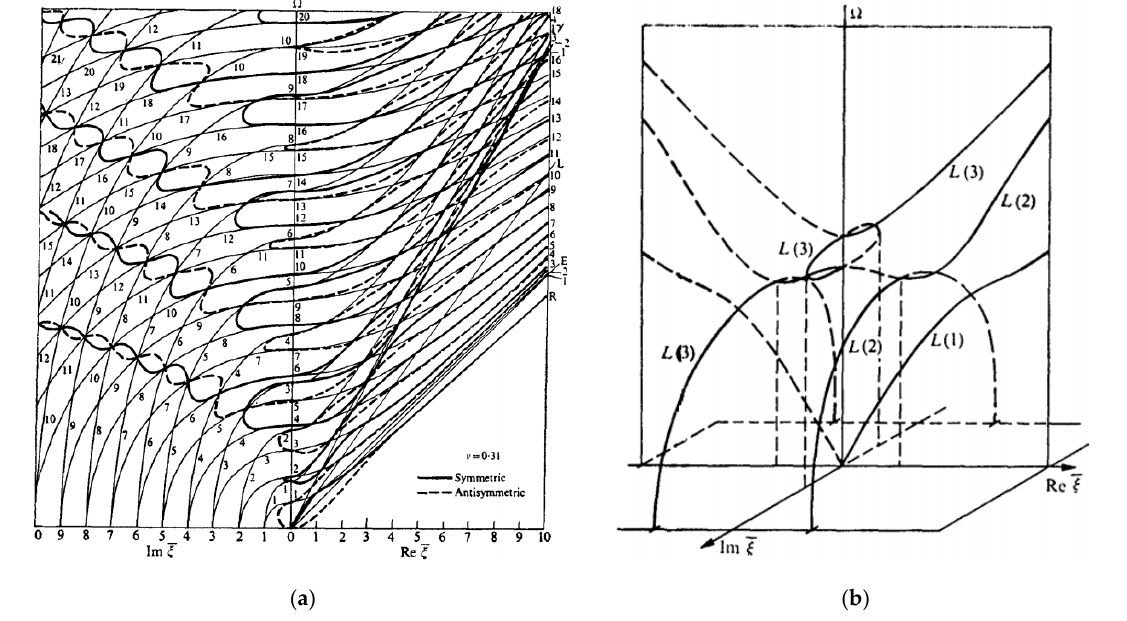
Figure 1. Frequency-wave number solution of Rayleigh-Lamb equations for mixed boundary in an isotropic plate ( υ = 0.31) ( a ) Real and imaginary wavenumber dispersion curves ( b ) 3D representation of the complex-wavenumber trajectories for the first three longitudinal modes [10].